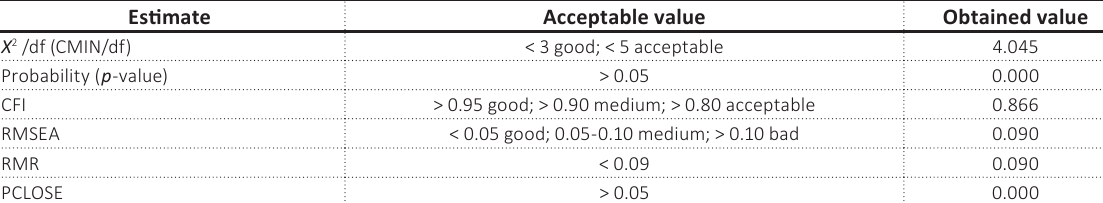
Table 6. Model fit the results of the SEM